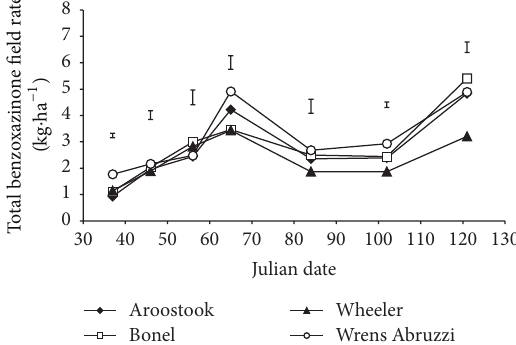
Figure 11: Benzoxazinone rate (concentration × biomass) at suc- cessive dates in rye foliage of four rye varieties during the first year of experiments. Vertical bars represent standard errors at each sampling